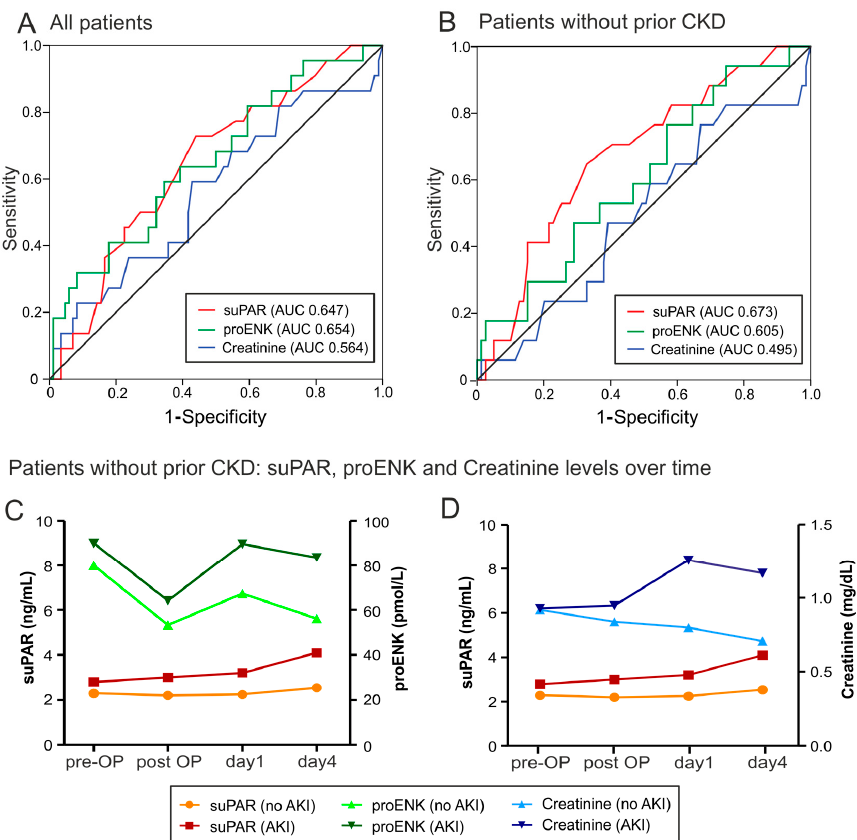
Figure 2. Predictive value of AKI biomarkers and longitudinal assessment. ( A ) and ( B ) receiver operating characteristic (ROC) curve analyses for pre-operative suPAR, proENK and creatinine to predict post-surgery AKI for all patients ( A ) and patients without prior CKD ( B ). ( C ) suPAR and proENK serum levels over time (pre- and post-operation, day 1 and day 4 after operation) for patients without prior CKD. ( D ) SuPAR and creatinine serum levels over time in patients developing AKI compared to patients without AKI development. AUC: Area under the curve.